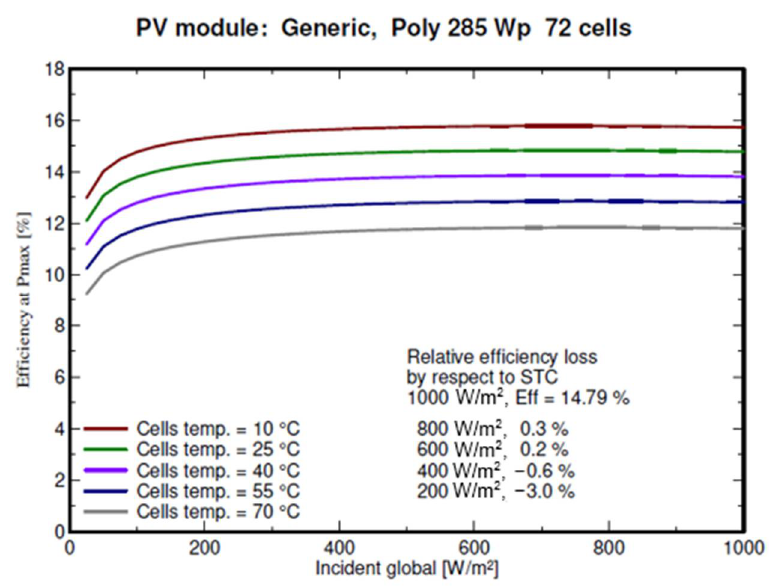
Figure 14. Figure showing FPV efficiency vs. irradiation curves.